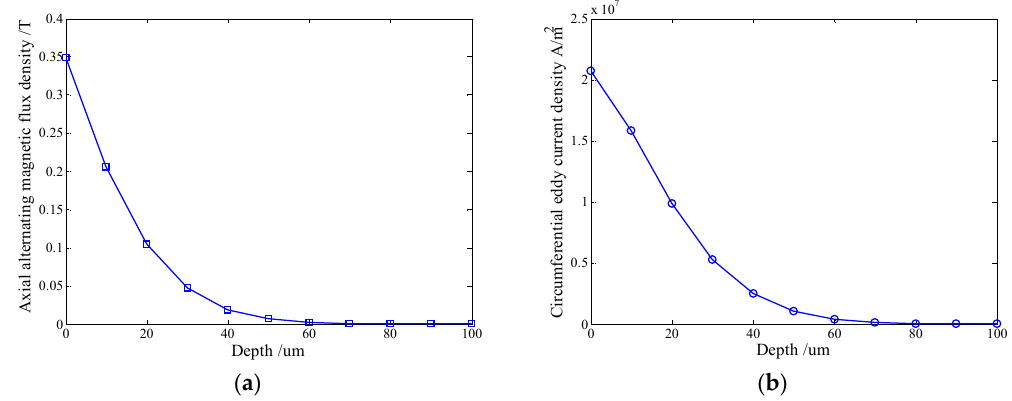
Figure 6. The distribution of ( a ) the axial alternating magnetic field ( b ) the circumferential eddy current density within 100 μ m beneath the outer surface.